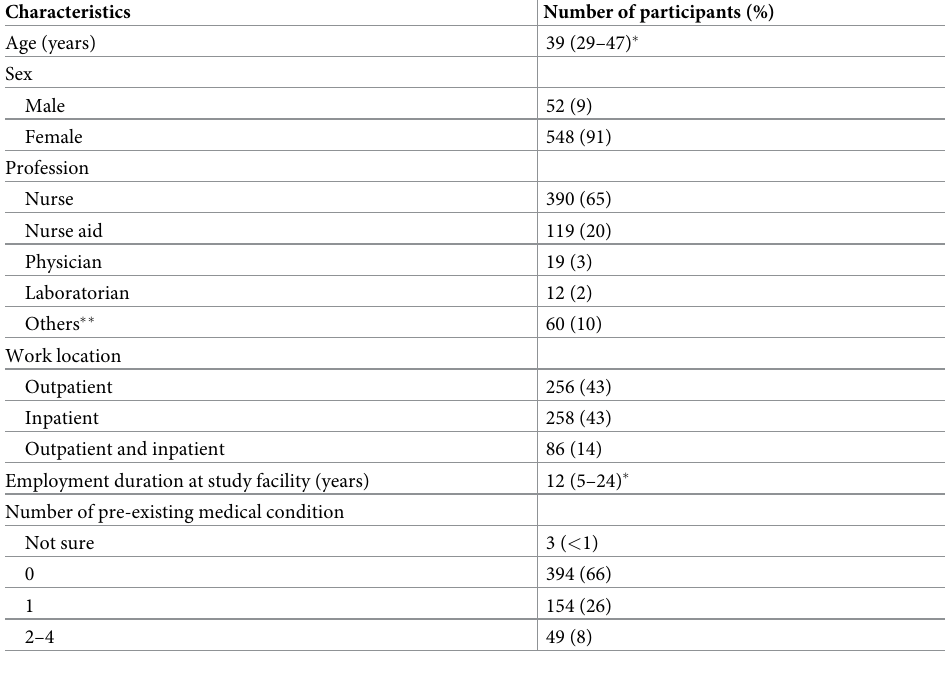
Table 1. Characteristics of study participants at enrollment (January-March 2021), Bangkok, Thailand.